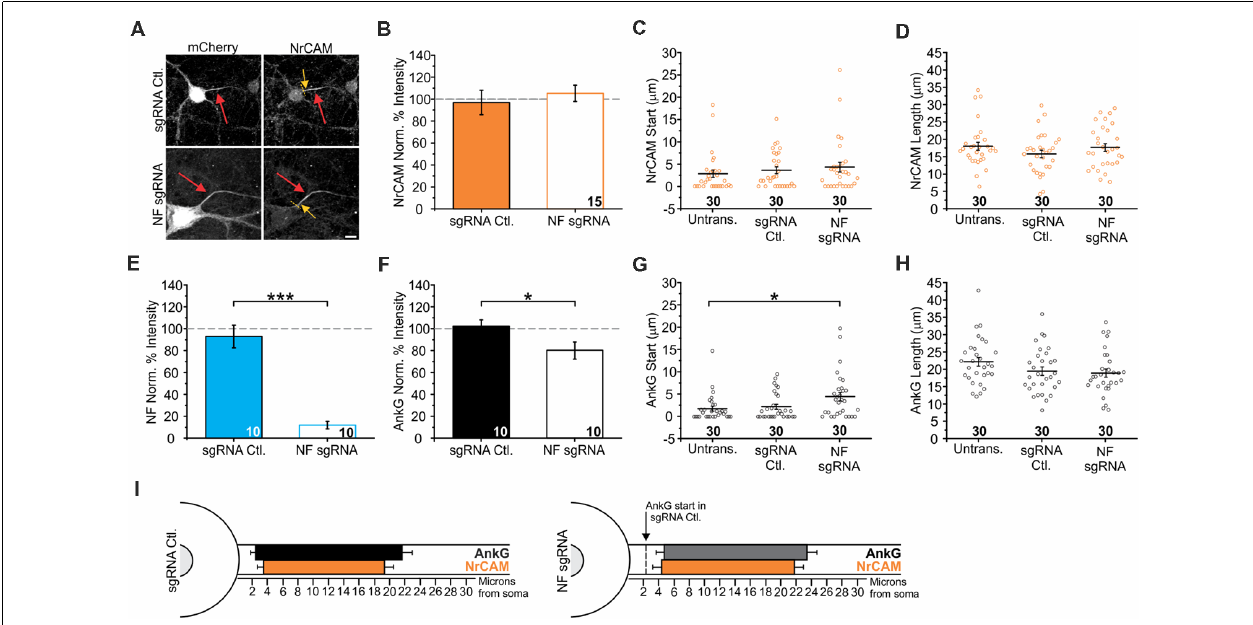
FIGURE 7 | Knockout of NF does not influence neuronal cell adhesion molecule (NrCAM) enrichment or relative localization. (A) Representative images of sgRNA control or NF sgRNA stained for mCherry with NrCAM. Red arrows indicate the AIS of transfected neurons; yellow arrows indicate start of AnkG enrichment; yellow dashed lines indicate junction of soma and axon. Scale bar: 10 µ m. (B,F) Ratio of mean fluorescence intensity of NrCAM (B) and AnkG (F) at the AIS in the same sgRNA control or NF sgRNA neurons, normalized to untransfected neurons in the same image ( B : n = 15 in both conditions. F : n = 15 for both conditions; ∗ p = 0.034, Student’s t -test). (C,G) Distance from the soma to start of AIS for NrCAM (C) and AnkG (G) in the same untransfected, sgRNA control, and NF sgRNA neurons ( C : n = 30 for all conditions. G : n = 30 for all conditions; ∗ p = 0.05, Kruskal-Wallis ANOVA followed by Dunn’s post-test with Bonferroni correction). (D,H) AIS length for NrCAM (D) and AnkG (H) in the same untransfected, sgRNA control, and NF sgRNA neurons ( D : n = 30 in all conditions. H : n = 30 in all conditions). (E) Ratio of mean fluorescence intensity of NF at the AIS in paired sgRNA control or NF sgRNA expressing neurons from the same culture as NrCAM data was taken, normalized to untransfected neurons in the same image ( n = 10 in both conditions; ∗∗∗ p < 0.001, Student’s t -test). Error bars indicate mean ± SEM. (I) To-scale distribution of AnkG (black) and NrCAM (orange) in sgRNA control (left) and NF sgRNA (right) neurons. Color saturation of bars are indicative of average labeling intensity of the population. Dashed black line indicates start of AnkG enrichment in sgRNA control. Left error bar indicates SEM for distance from the soma, right error bar indicates SEM for length; data taken from (B–D) and (F–H)